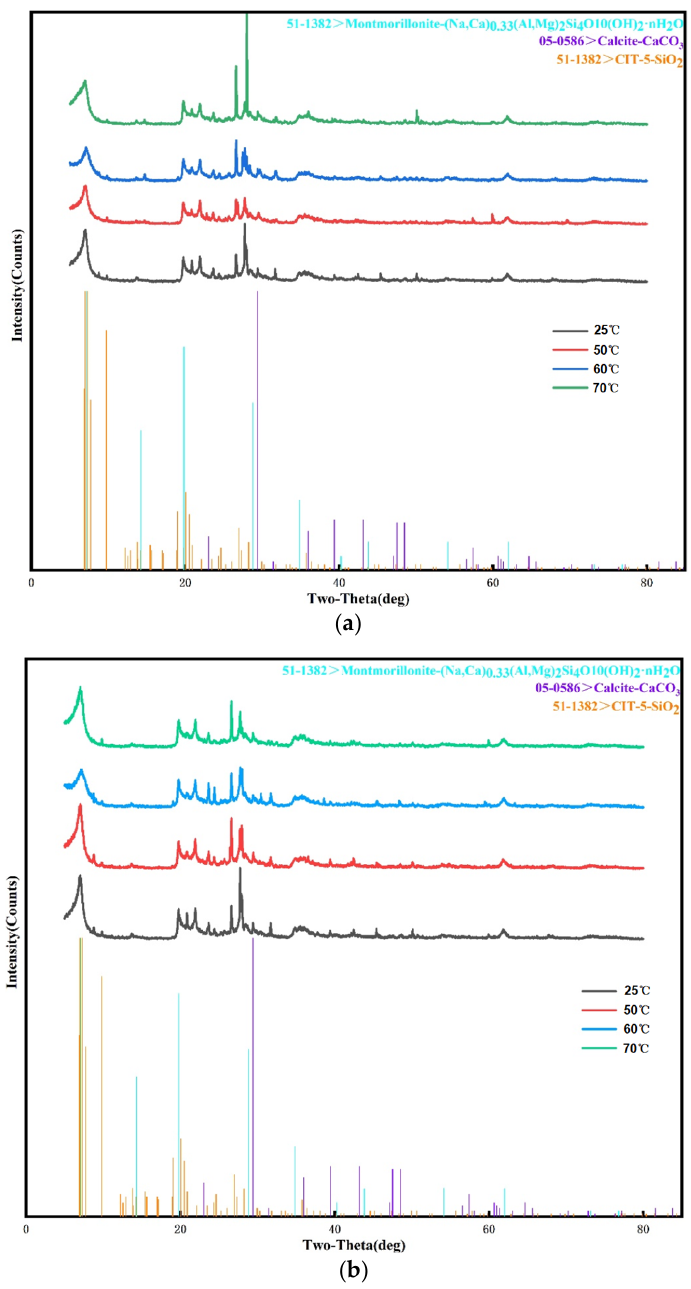
Figure 4. XRD spectrum of bentonite at different temperatures (( a ) bentonite B+Xikuangshan mining leachates and ( b ) bentonite B+Baojinshan mining leachates). Table 4. X-ray fluorescence element content of Bentonite in Baojinshan leachate.